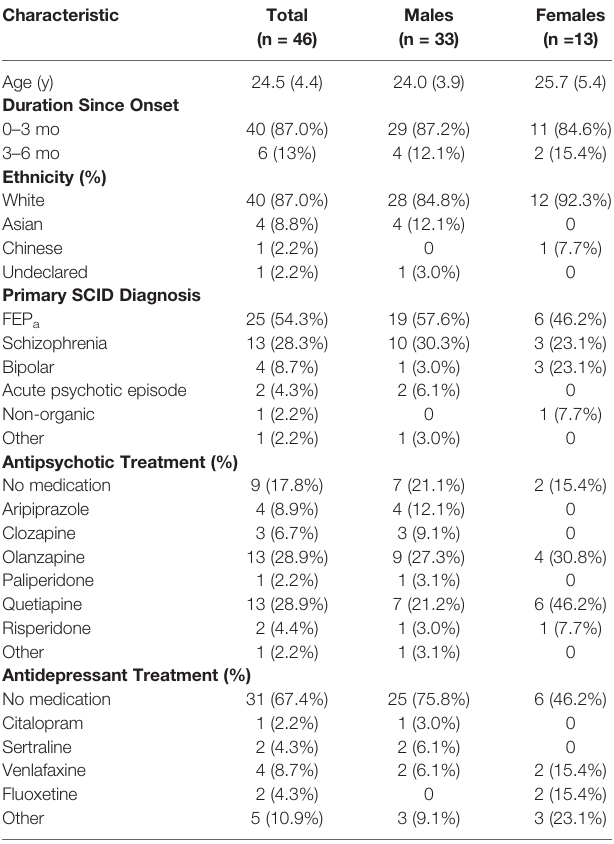
TABLE 1 | Demographics, illness, and treatment characteristics by